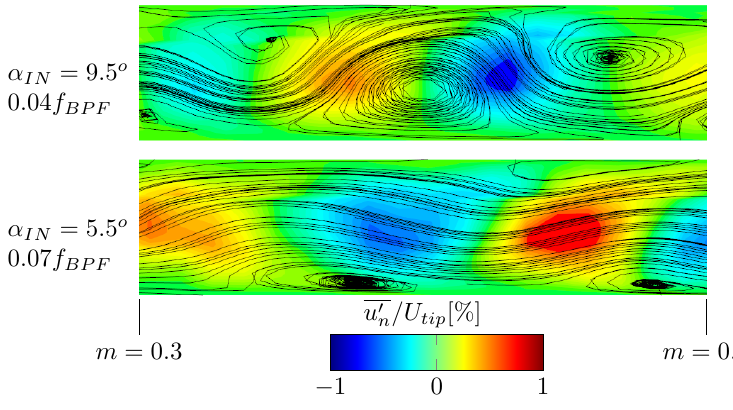
Figure 10. Fourier surface spectra decomposition of the wall normal velocity fluctuation colored on the side view plane, between meridional stations m = 0.3 and m = 0.4. Constrained streamlines are overlayed for the corresponding to the flow modes α IN = 9.5 ◦ and α IN = 5.5 ◦ ,